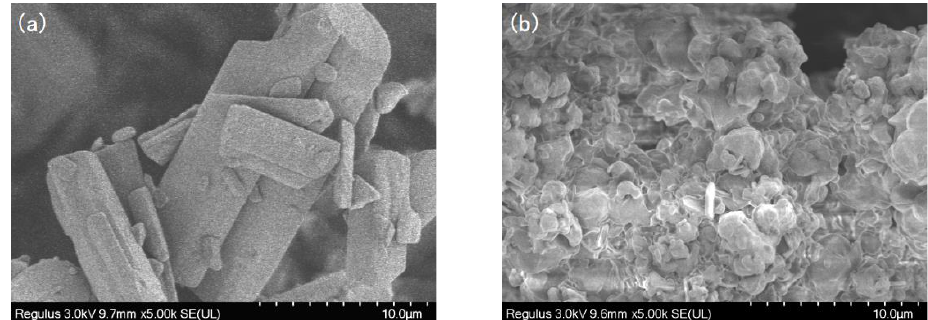
Figure 2. SEM images of SIM ( a ) and SA/SIM particles ( b ).